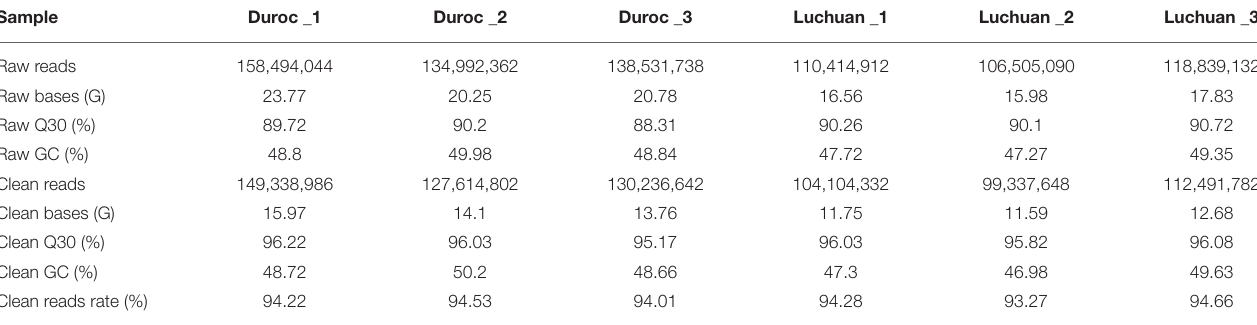
TABLE 2 | ATAC-seq data